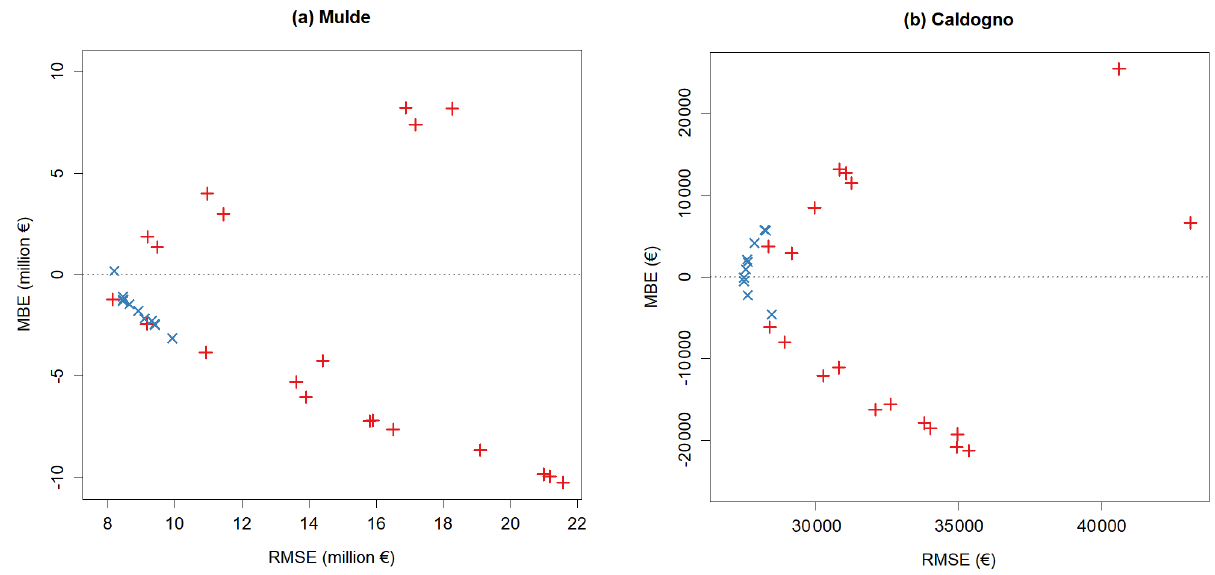
Figure 5. RMSE and MBE of the EEM-ensemble means, represented by blue crosses, and single model predictions, by red plus